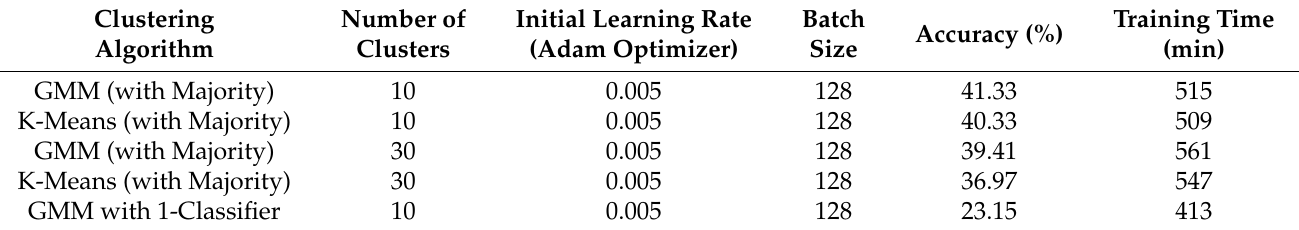
Table 7. Results of the NTU-RGB+D 120 dataset.